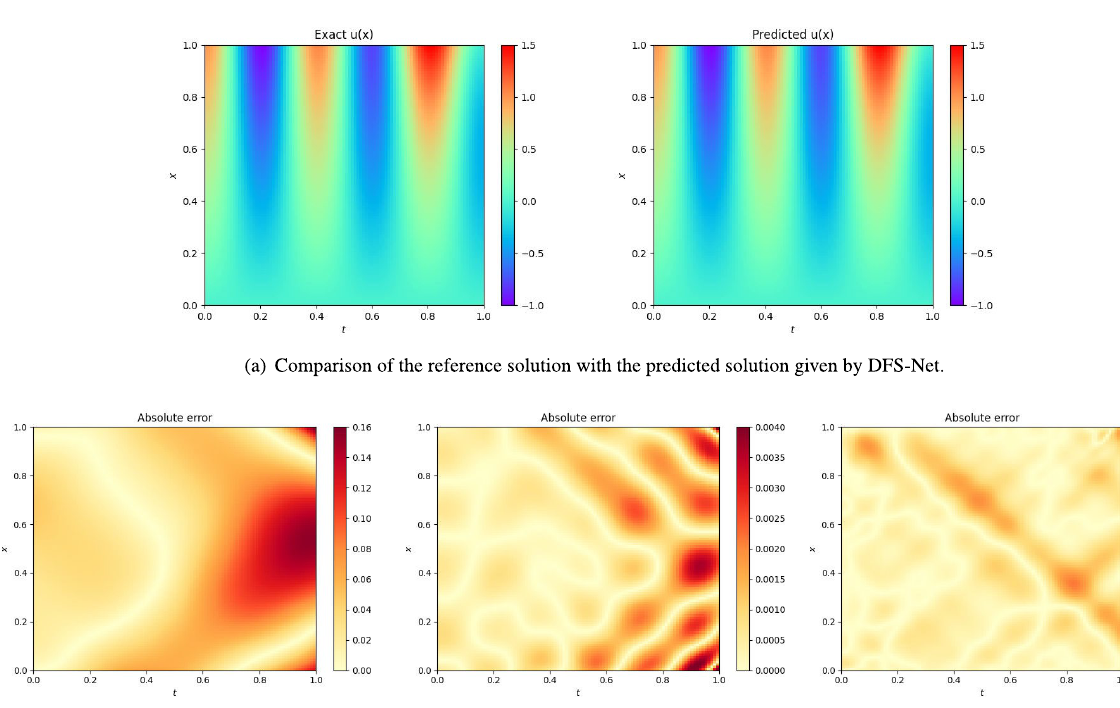
Figure 5. Performance of different surrogate models on the Klein–Gordon equation.